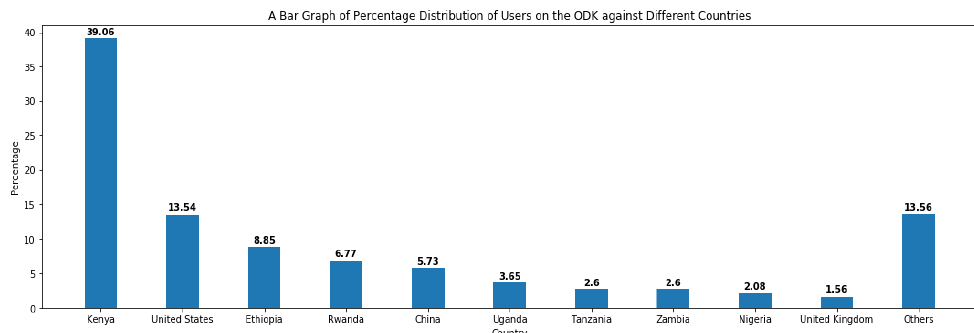
Figure 8. Data warehouse—percentage distribution of users by country.